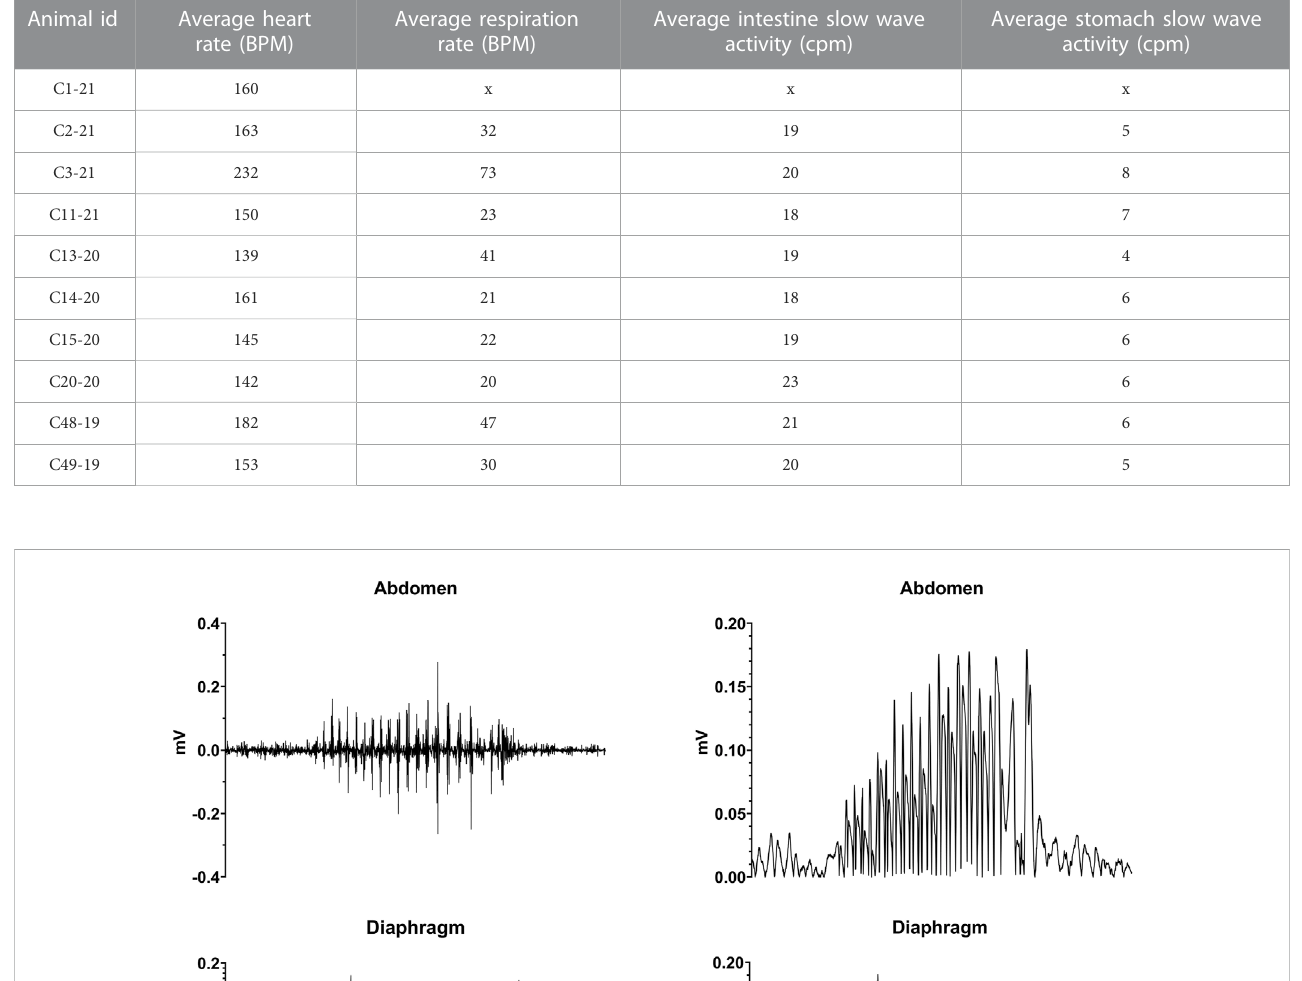
TABLE 3 Baseline physiological measurements for each animal. X — data not acquired.